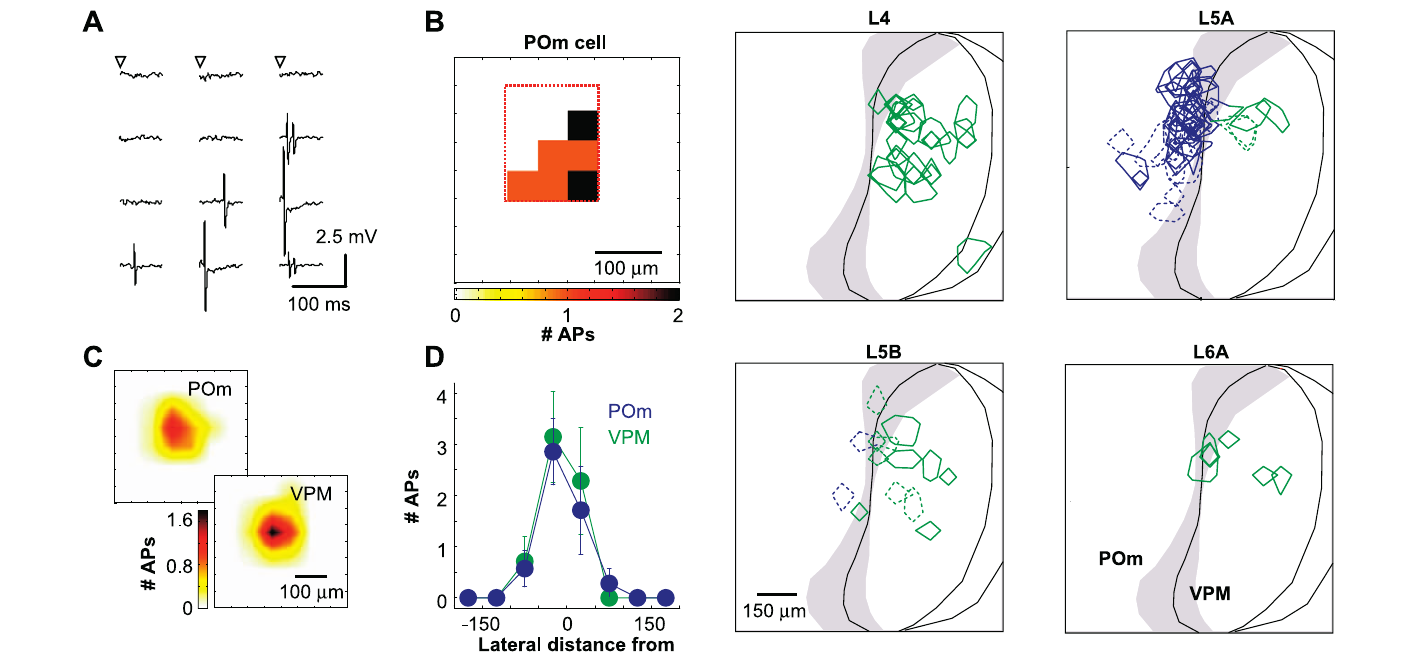
Figure 3. Laminar Organization of Thalamocortical Projections Overlay of input domains for L4, L5A, L5B, and L6A cells. The contours enclose regions where the inputs exceed 50% of the largest responses (VPM, green; POm, blue). Dashed contours correspond to pyramidal cells with apical dendrites that were cut below L1. Shaded area denotes the range of POm/VPM boundaries for all experiments. DOI: